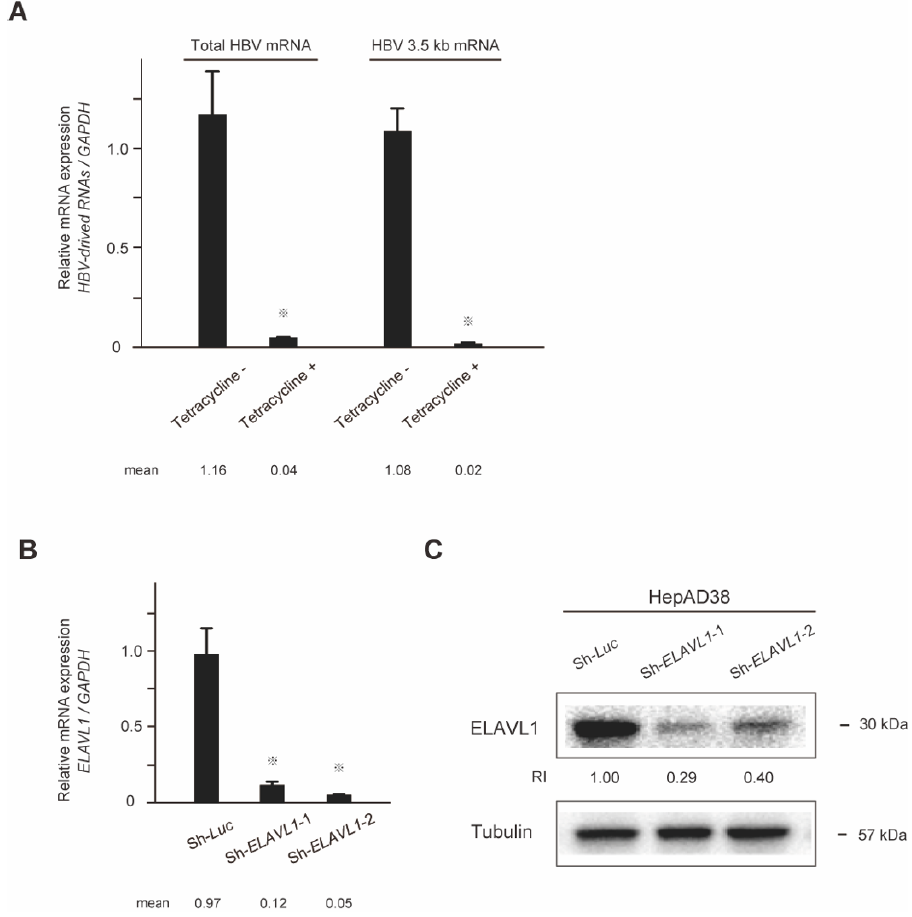
Figure 1. In vitro assays of HepAD38 cells. Depletion of tetracycline triggers viral replication as viral replication is under the control of a promoter that is repressed by tetracycline. ( A ) Total HBV mRNA and 3.5 kb mRNA levels of HepAD38 cells in the presence or absence of tetracycline were determined via quantitative real-time PCR analyses. Data represent the mean with SD of triplicate experiments (Student’s t -test, ※ p < 0.05). ( B ) ELAVL1 -knockdown HepAD38 cells in the absence of tetracycline were subjected to quantitative real-time PCR analyses for ELAVL1 mRNA expression. Data represent the mean with SD of triplicate experiments (Student’s t -test, ※ p < 0.05). ( C ) HepAD38 cells with stable knockdown of ELAVL1 in the absence of tetracycline were subjected to Western blot analyses using anti-ELAVL1 and anti-tubulin antibody (loading control). Relative intensities (RI) were determined by normalizing band intensities to those of internal controls.